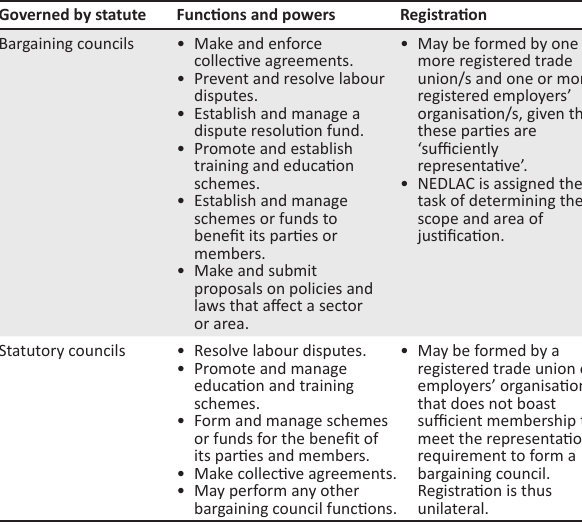
TABLE 1: Levels of statutory bargaining in South